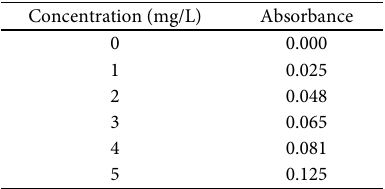
Table 1. Standard calibration curve